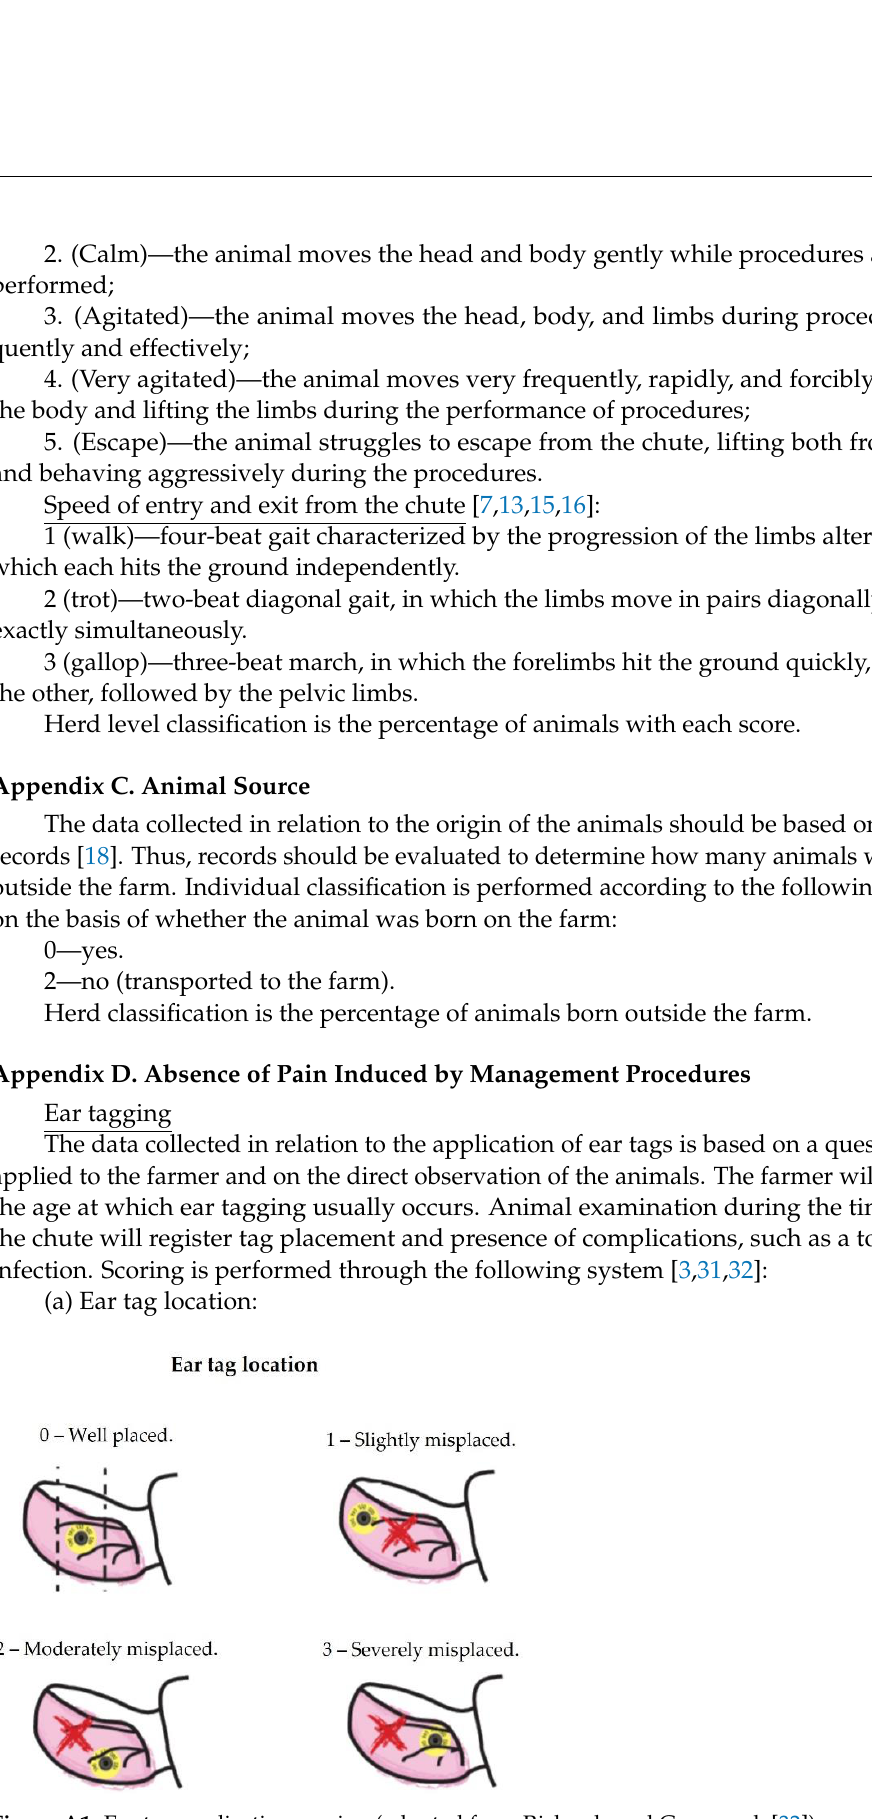
Figure A1. Ear tag application scoring (adapted from Richards and Gosz, n. d. [32]).